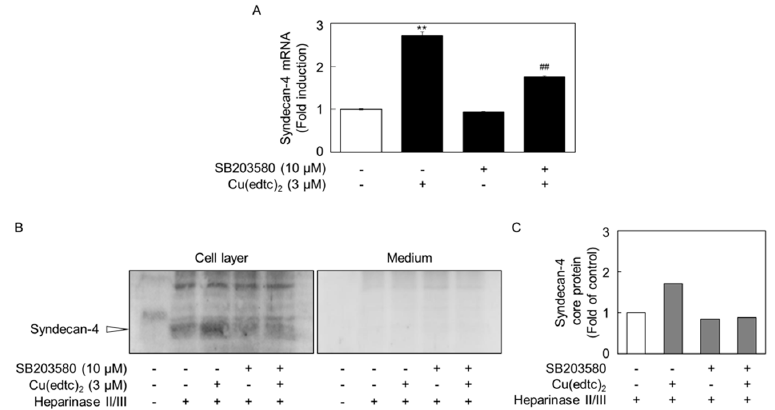
Figure 6. A p38 MAPK inhibitor SB203580 suppresses the syndecan-4 induction by Cu(edtc) 2 in vascular endothelial cells. The expression of syndecan-4 ( A ) mRNA and (B) core protein; values are means ± S.E. of four replicates. ** p < 0.01 vs. control; ## p < 0.01 vs. Cu(edtc) 2 . The position of syndecan-4 core protein is indicated by the arrowhead; ( C ) the intensity of the blots of cell layer in ( B ); the cells were treated with Cu(edtc) 2 (3 µM) for 8 h after pretreatment with of SB203580 (10 µM) for 3 h. Values are means of two replicates from two independent experiments ( C ).